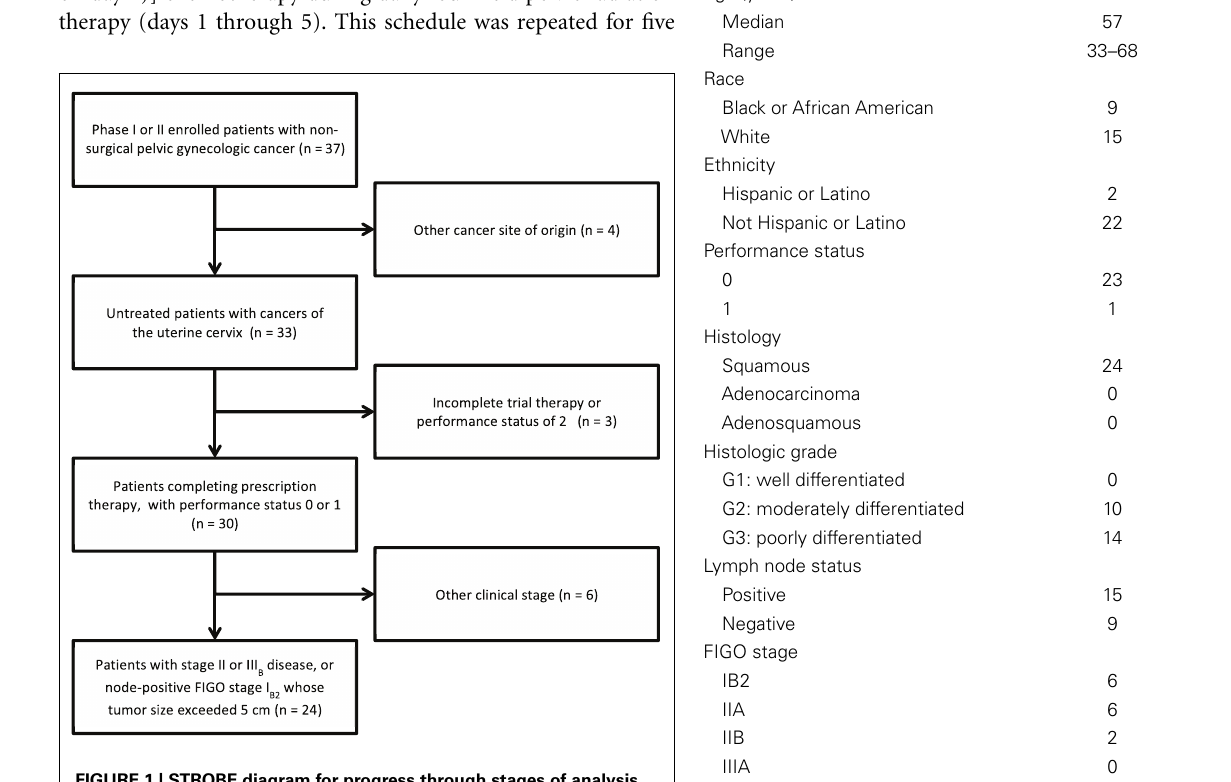
FIGURE 1 | STROBE diagram for progress through stages of analysis . STROBE, strengthening the reporting of observational studies in epidemiology.